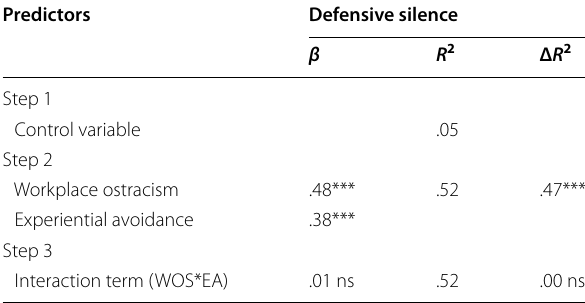
Table 7 Moderated regression